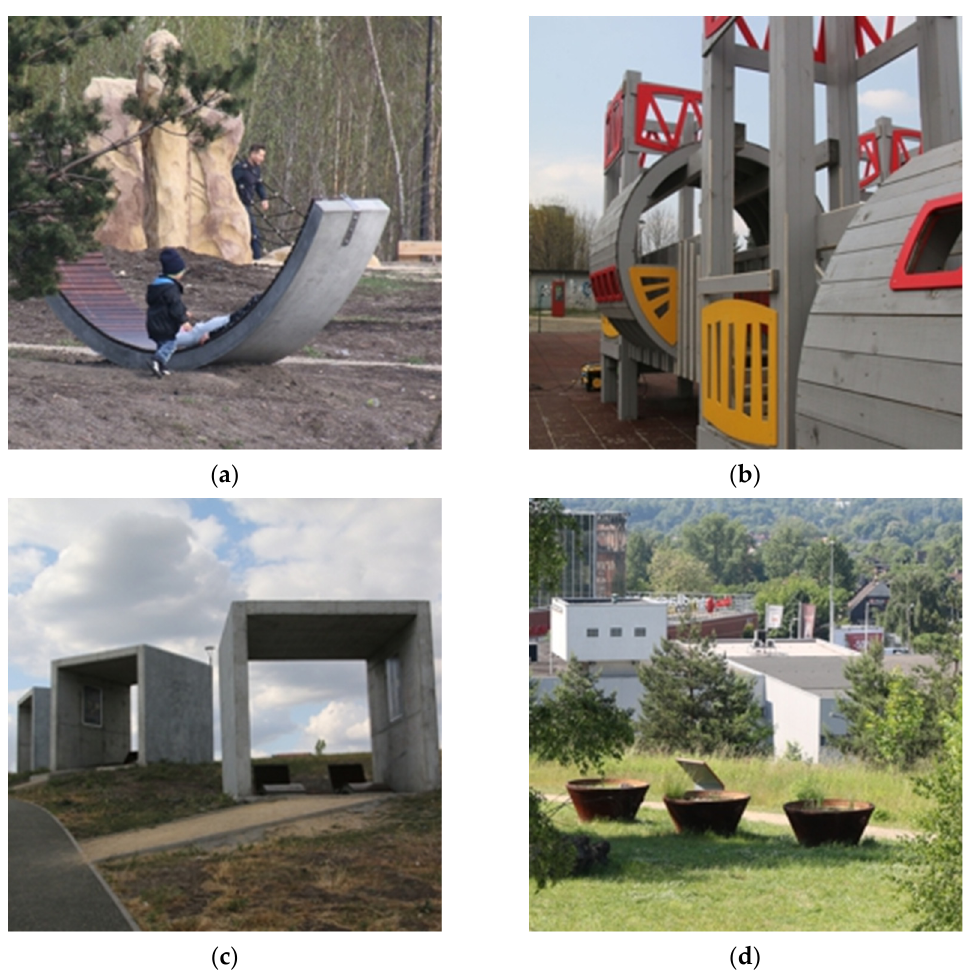
Figure 7. Original elements of small architecture designed for Antonia Hill: ( a ) The arched benches serving as handles for hammocks or deck chairs; ( b ) the construction resembling blast furnaces; ( c ) the observation boxes; ( d ) the historic smelt- ing